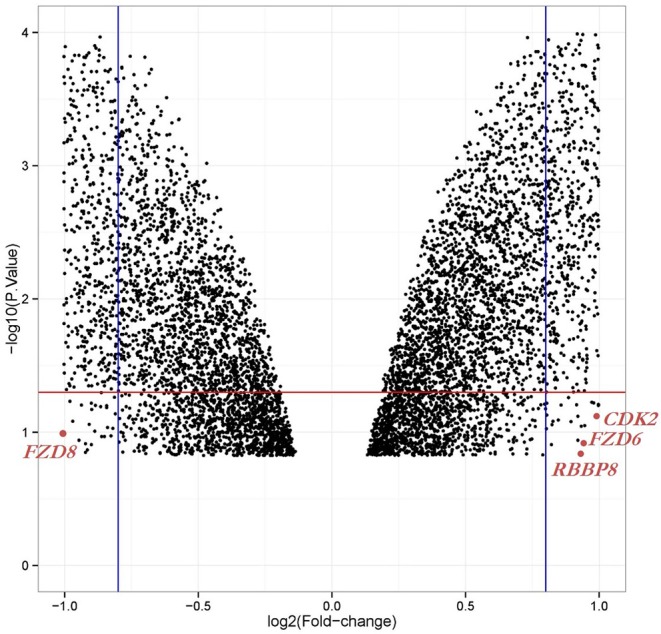
Volcano plot of the DEGs in OC compared with those in SINE-resistant OC from the GSE126519 dataset. x-axis: log2FC, large-scale fold changes; y-axis: –log10 of the p-value showing the statistical significance. Each black point corresponds to one gene. The black points above the red line and beside the blue line (left side and right side) represent log2FC ≥ 1 and p-value < 0.05; all DEGs that were OC-related are shown below the red line, which represents log2FC < 1 or p-value > 0.05. The position of the core genes are named and marked in scarlet color.